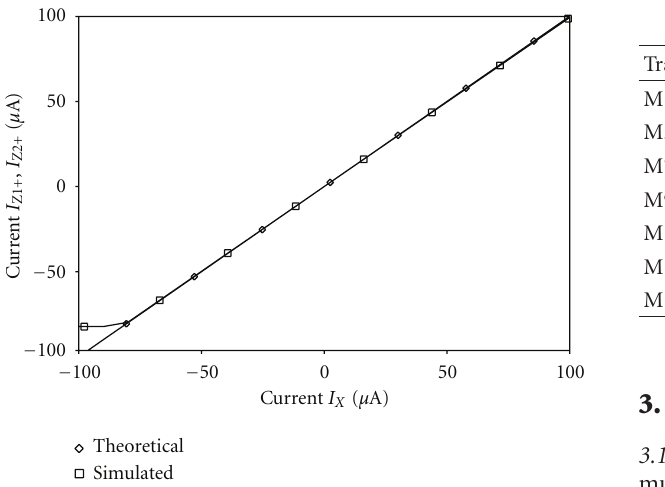
Figure 4: DC transfer characteristic for current transfer from X port to Z 1+ and Z 2+ ports.